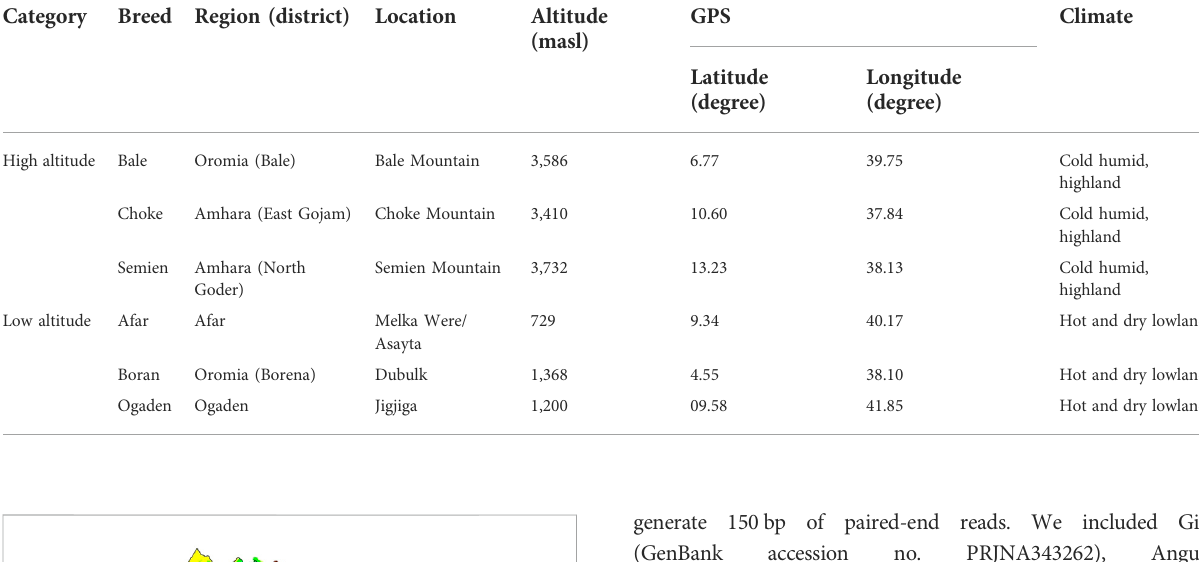
TABLE 1 Sampling location and cattle population description in the high and low altitudes.